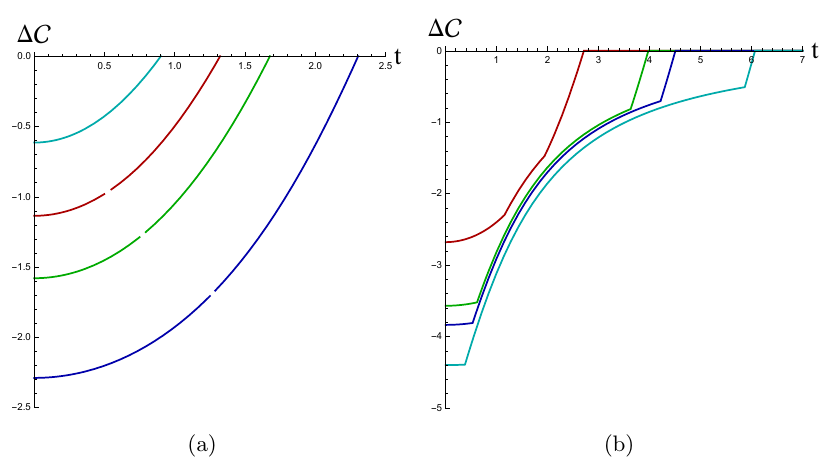
Figure 8 . (a) Evolution of (cid:1) C in the case of a mild quench, ‘= 4 < (cid:11) < ‘= 2. Di(cid:11)erent curves correspond to ‘ = 3 : 5 ; 4 ; 4 : 5 ; 5 : 5 (from top to bottom); (cid:11) = 1 : 5. (b) The same quantity in the